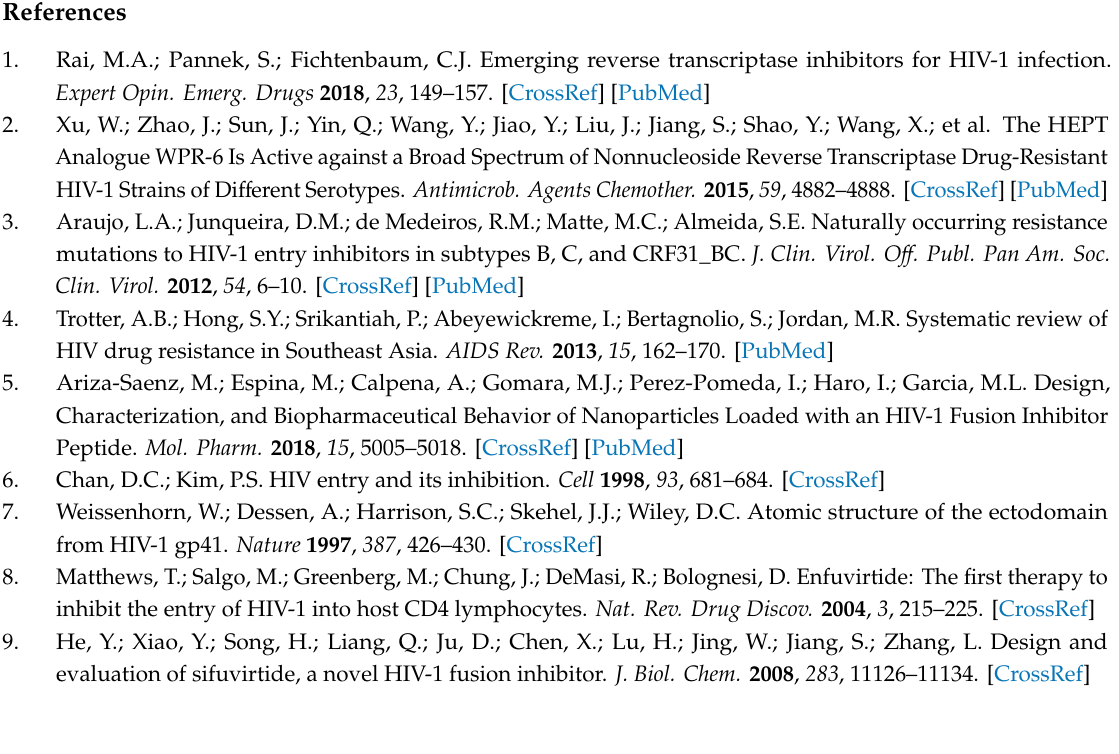
Table S1: The detail information about the EC 50 of PEGylated peptide against each virus. Table S2: The detail information about the HIV gp41